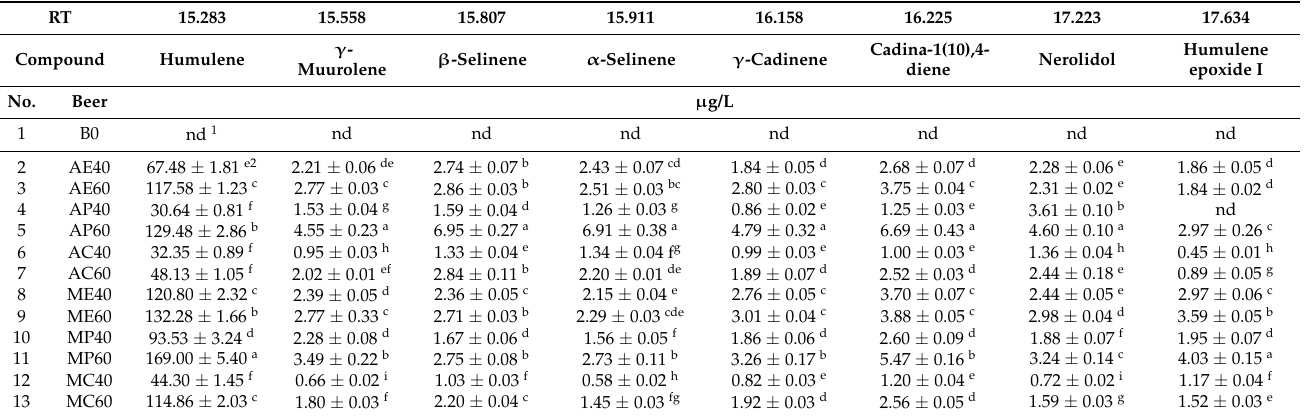
Table 3. Hop volatile compounds